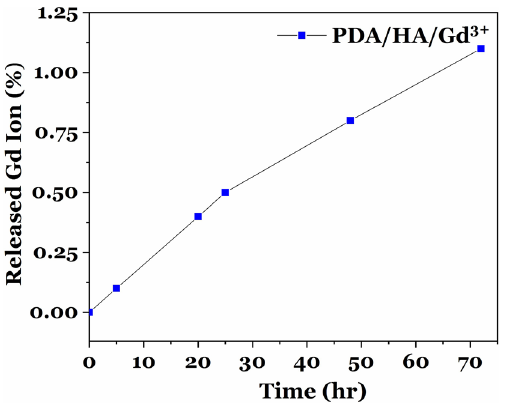
Figure 11. The percentage of gadolinium ions released from PDA/HA/Gd 3+ NPs during 72 h.